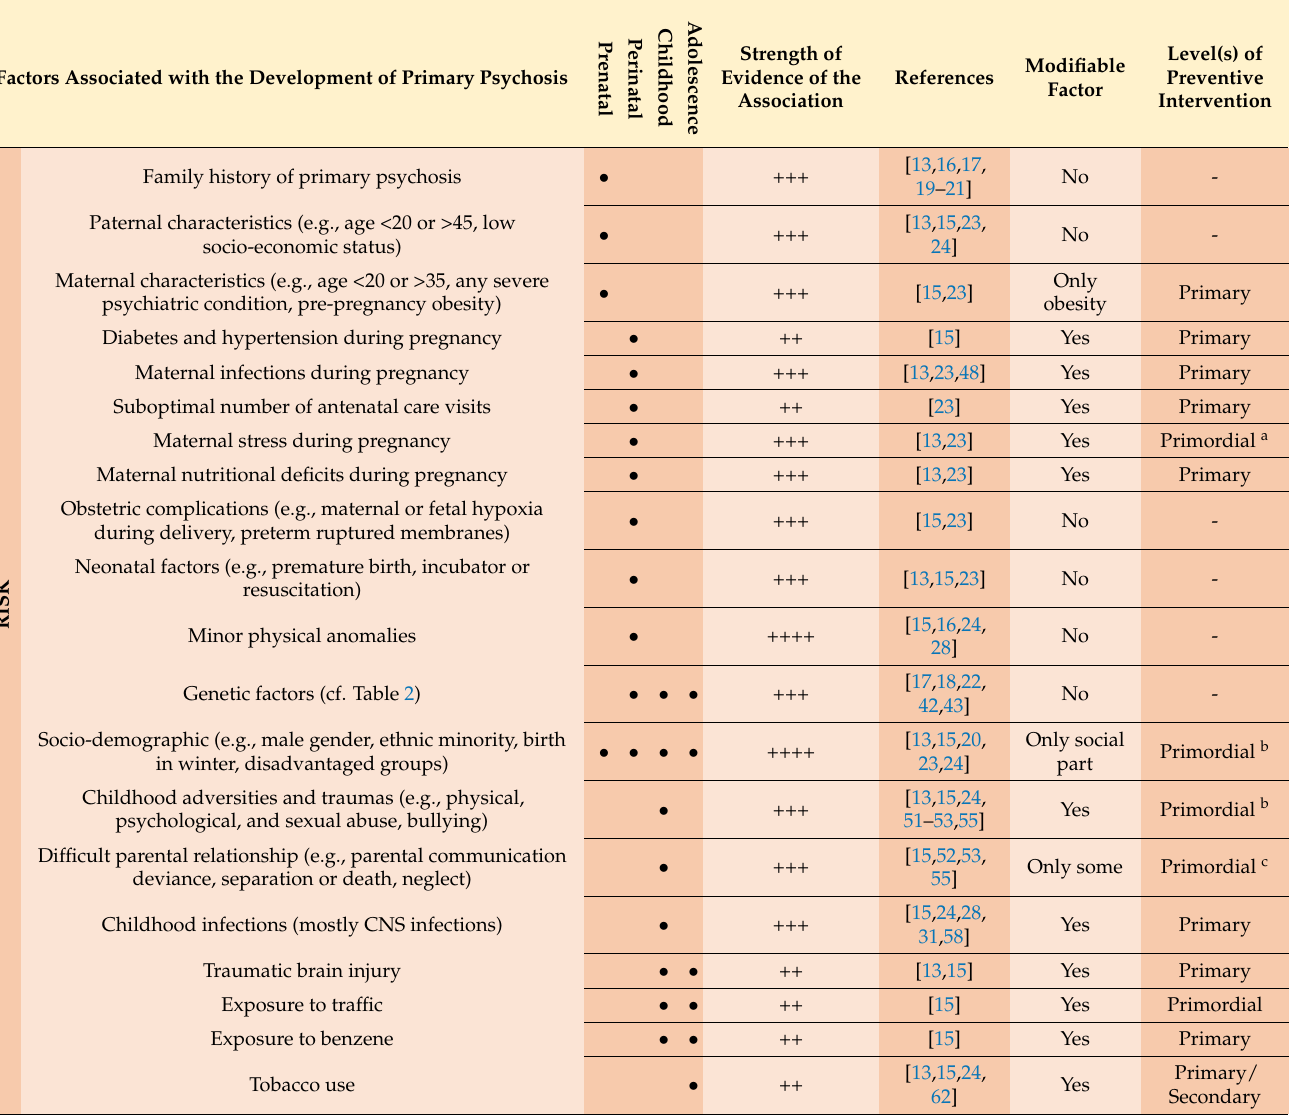
Table 2. Risk and protective factors of primary